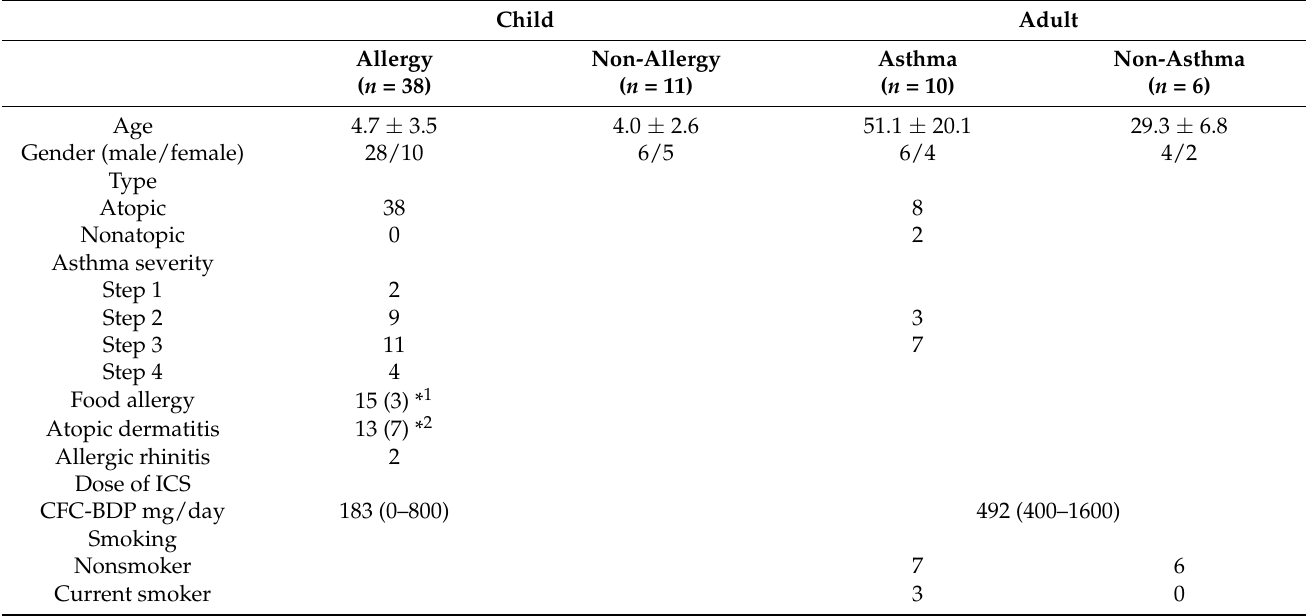
Table 1. Clinical characteristics of study